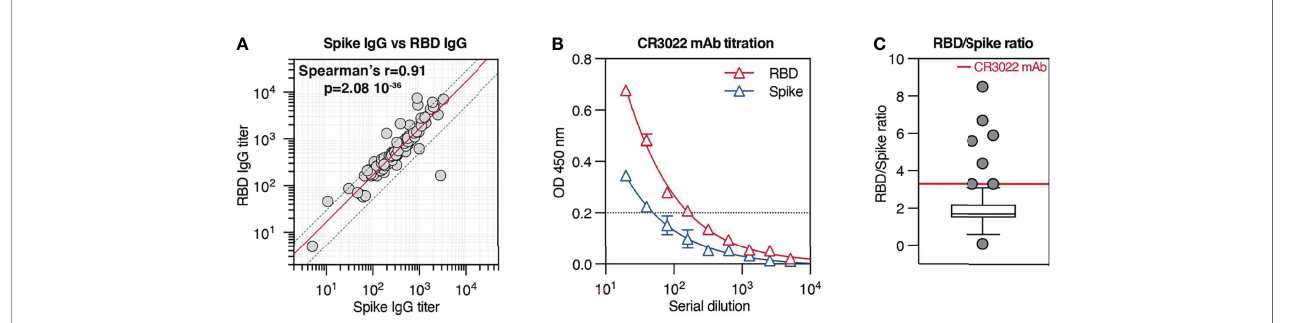
FIGURE 5 | Spike IgG antibodies generated after natural COVID-19 infection are not polarized toward the receptor-binding domain (RBD) region. (A) Correlation between Spike IgG titer and RBD IgG titers across all patients from our cohort. The red solid line indicates the mean RBD/Spike titer ratio (1.7), while the two dotted lines indicate the SD ( ± 1.2). (B) Spike and RBD IgG titration (mean ± SD) by ELISA across 9 serial dilutions of the anti-RBD monoclonal Ab CR3022. (C) Ratio between RBD and Spike IgG titers across all patients in the cohort. Results are in box-and-whiskers plot (Tukey) indicating cohort distribution (right panel, only individual data outside from the whiskers are displayed with a symbol). The red line indicates the RBD/Spike titer ratio relative to CR3022